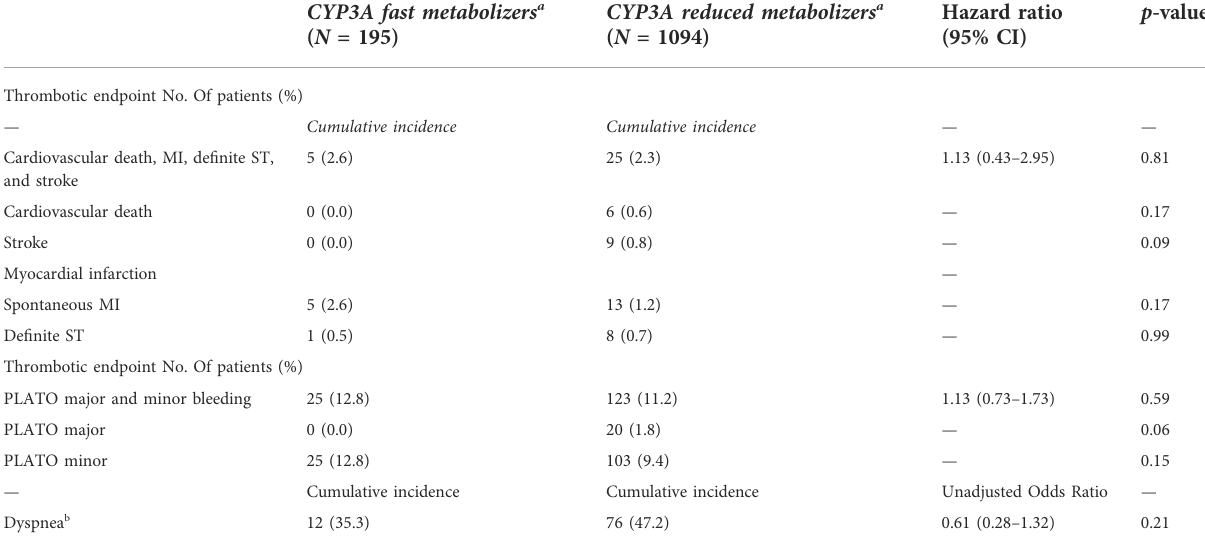
TABLE 4 Clinical endpoint for CYP3A fast metabolizers versus CYP3A reduced metabolizers in patients treated with